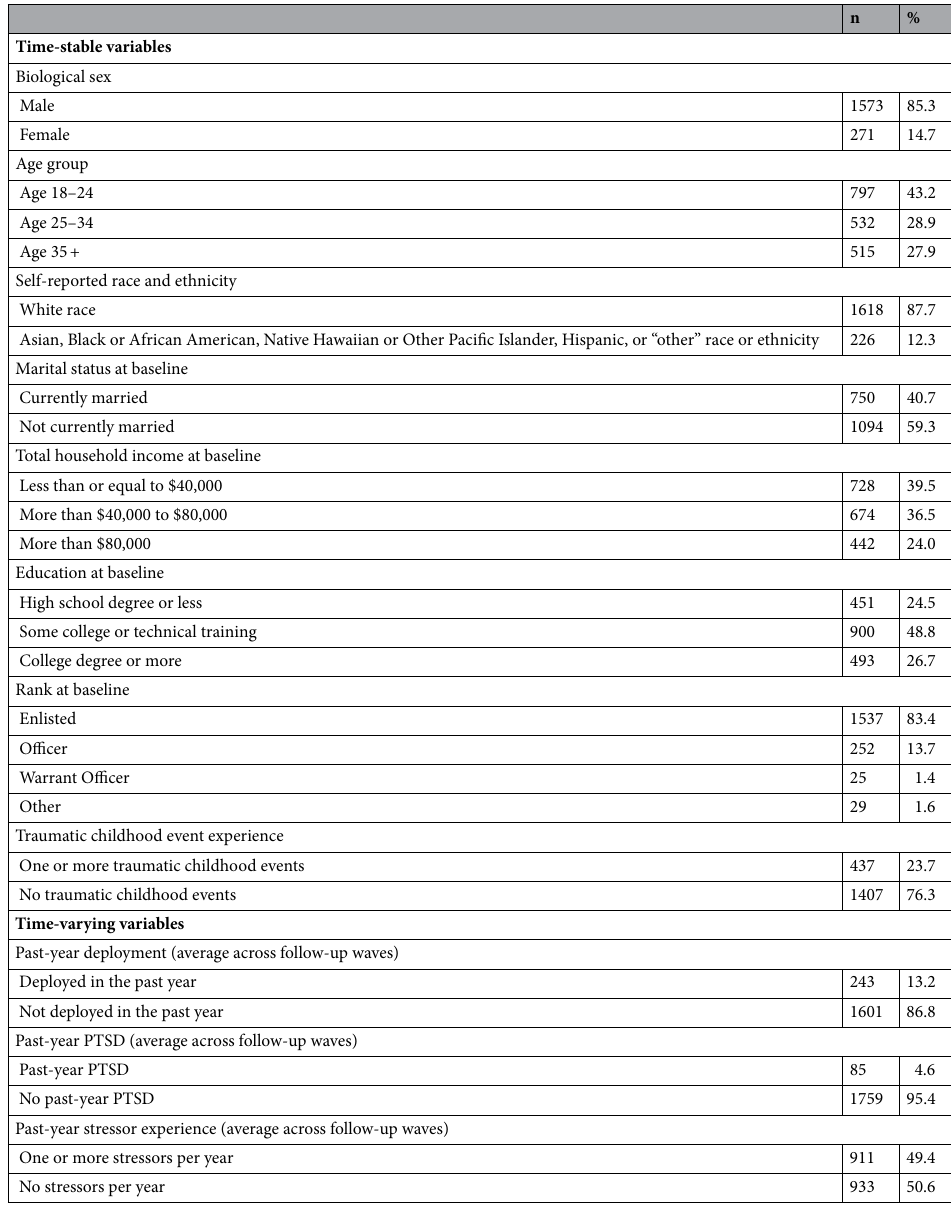
Table 1. Sample characteristics: frequencies of confounders and exposures of interest (n = 1844). PTSD = posttraumatic stress disorder. One participant was missing on rank and was not included in the percentages for that